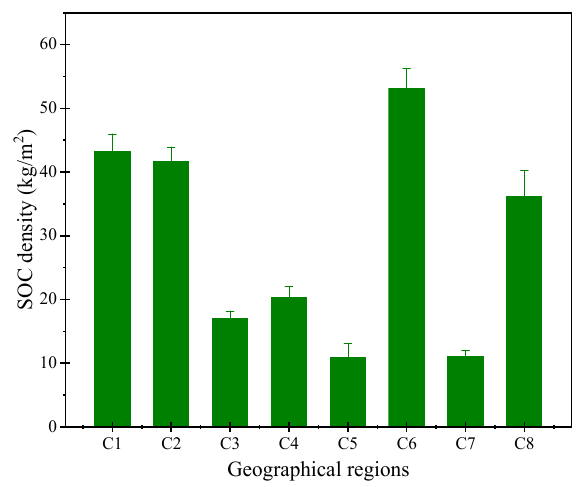
Figure 4. SOC density in the eight geographic regions.